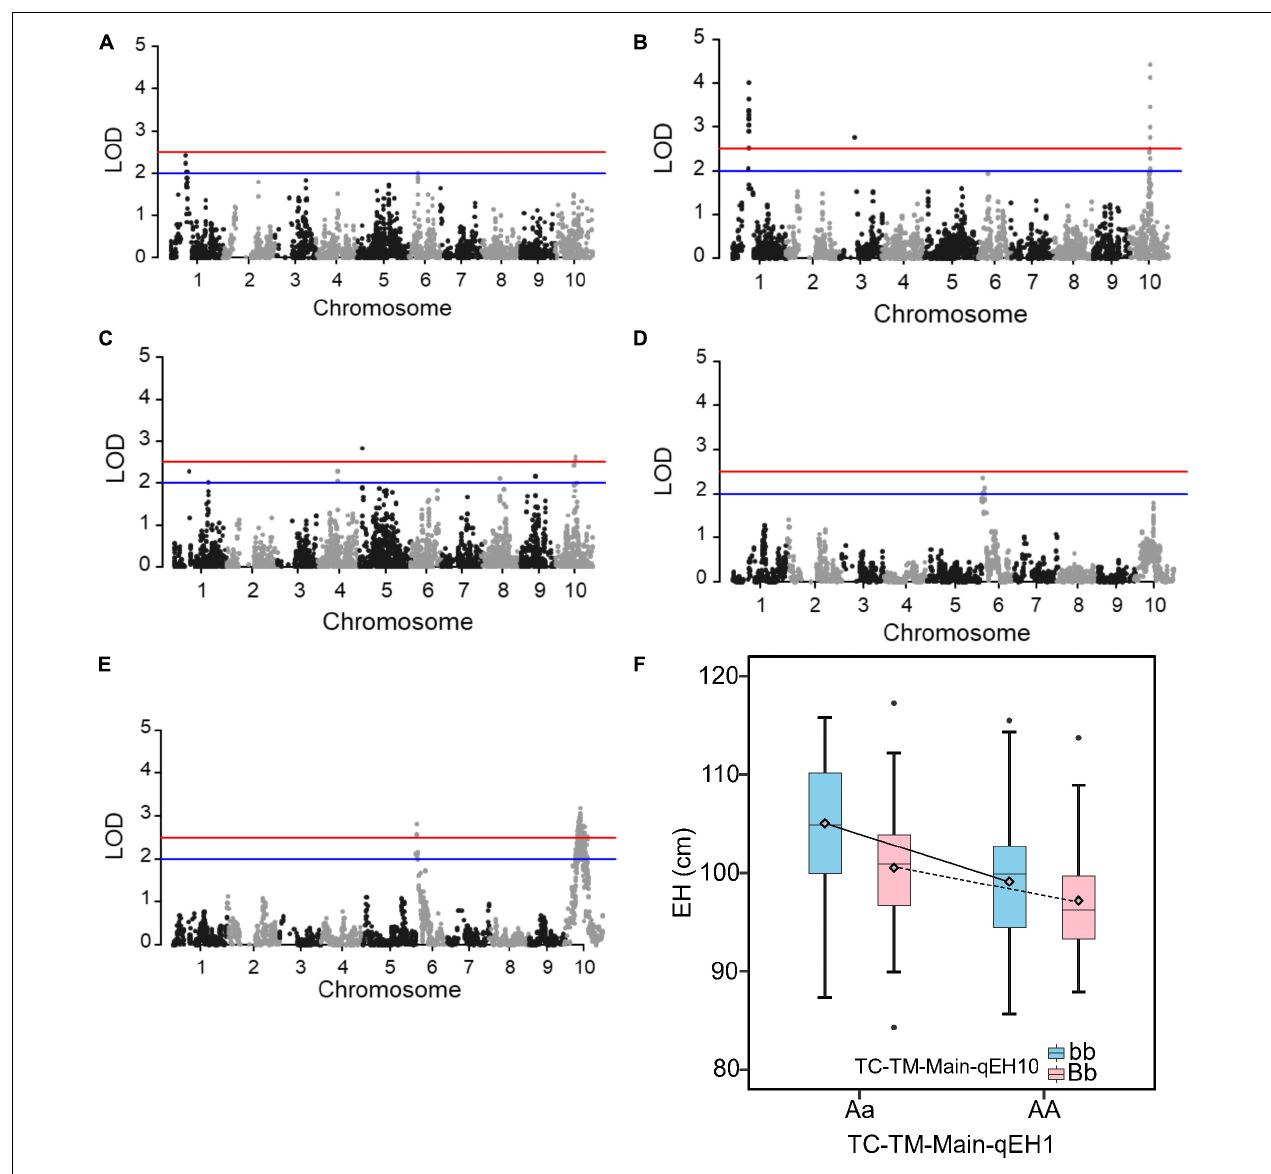
FIGURE 5 | Quantitative trait loci (QTL) mapping results for the trait ear height. (A) QTL mapping in the recombinant inbred line population developed by Ye478 × Qi319 (RIL) population. (B) In the pooled Chang7-2 × RIL (TC)-Mo17 × RIL (TM) population, and (C) dominance QTL mapping for midparent heterosis. (D) Test for epistasis between the QTL TC-TM-Main-qEH1 (peak single nucleotide polymorphisms is Chr1_131115160) on chromosome 1 and the other 4,140 markers in the RIL population. (E) Test for epistasis between the QTL TC-TM-Main-qEH1 (peak single nucleotide polymorphisms is Chr1_131115160) on chromosome 1 and the other 4,140 markers in the pooled TC-TM population. The red horizontal line indicates the significance threshold used for QTL detection and the blue line is the threshold to identify the loci for the favorable QTL analysis. (F) The interactions between different genotypes of QTL TC-TM-Main-qEH1 (Chr1_116118501; Aa, AA) and different genotypes of QTL TC-TM-Main-qEH10 (Chr10_91890676; bb, Bb). The diamond indicates the mean value of different genotypes. LOD, log of